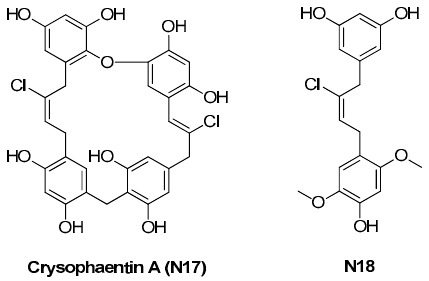
Figure 5. Chrysophaentin FtsZ inhibitors. Table 4. MICs of chrysophaentins